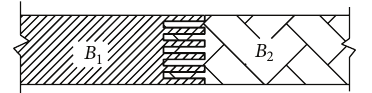
Figure 1: Superposed domains and the gluing zone 𝐸 .